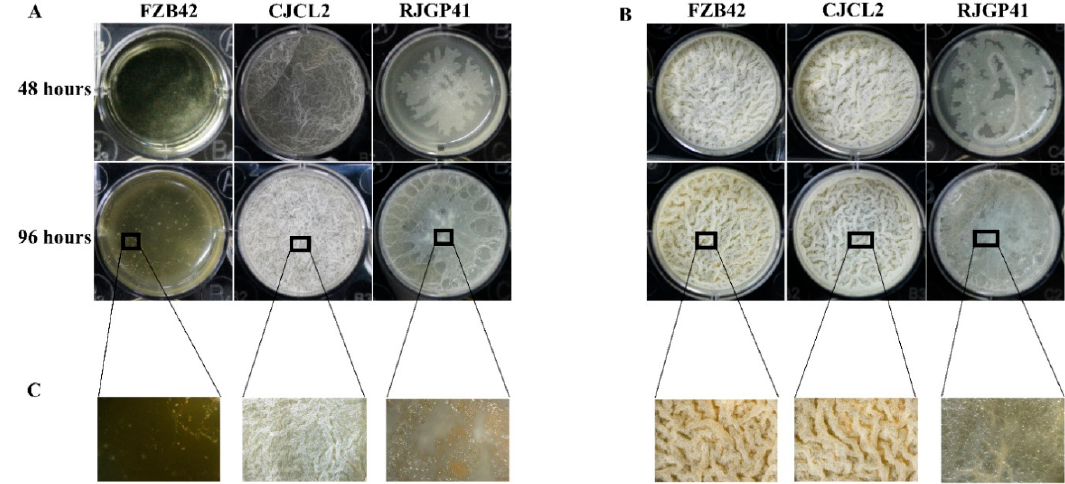
Figure 5. The biofilm formation potential of selected strains grown under cold stress (4 °C) ( A ). Biofilm formation ability of bacterial strains at optimum temperature, i.e., 37 °C (B) . The 20 × images ( C ).